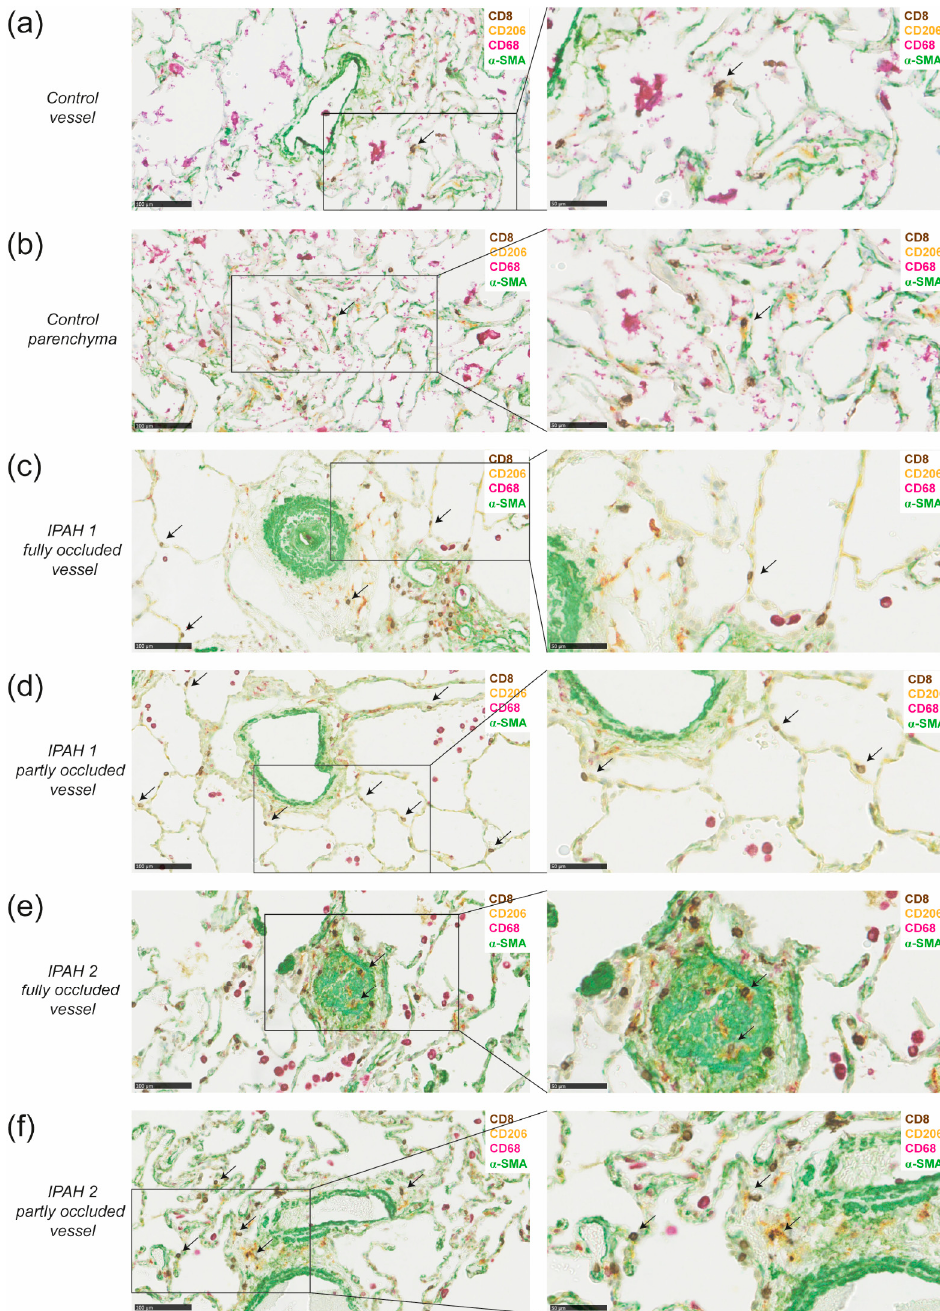
Figure 5. DCs are in close proximity to CD8+ T cells around vessels and in parenchyma in lungs of idiopathic pulmonary arterial hypertension (IPAH) patients. ( a , b ) 4-plex chromogenic multiplex staining of DCs (CD206+, yellow), macrophages (CD68+, purple with or without CD206), T cells (CD8, DAB) and α -SMA (green) around a vessel and intraparenchymal ( a ) or in parenchyma ( b ) and the magnification of the indicated area (right) in the same healthy tissue from a smoking patient who was diagnosed with adenocarcinoma; ( c , d ) determination of DCs (CD206+CD68-), CD8+ T cells (CD8+), macrophages (CD68+) and vessels ( α -SMA) around a fully occluded vessel ( c ) or partly occluded vessel ( d ) and the magnification of the indicated area (right) of the same IPAH patient with moderate remodeling; ( e , f ) determination of DCs, CD8+ T cells, macrophages and vessels around a fully occluded vessel ( e ) or partly occluded vessel ( f ) and the magnification of the indicated area (right) of the same a IPAH patient with extensive remodeling and immune cell infiltration. Data shown are representative for 6 IPAH patients. Sporadic CD206+CD68- cells with a morphology suggesting neutrophil identity were not regarded as DCs. Scale in left panels is 100 µ m and of right panels 50 µ m. Arrows indicate DC and CD8